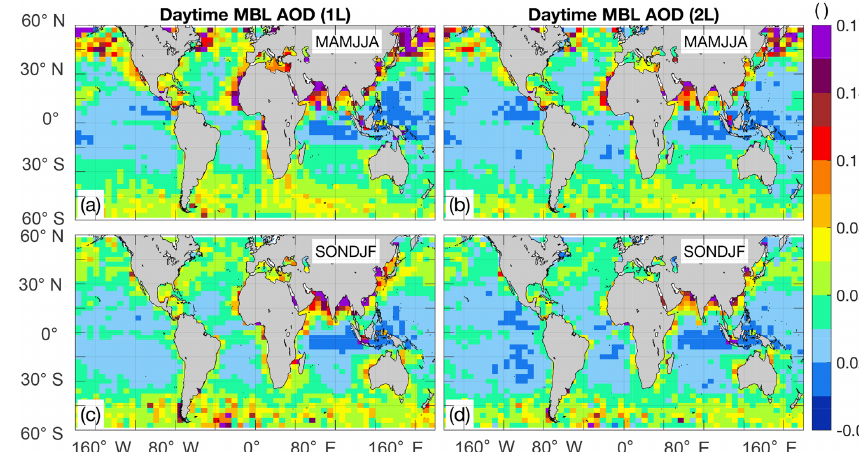
Figure 13. Daytime MBL 532nm AOD based on 1L (a, c) and 2L (b, d) .